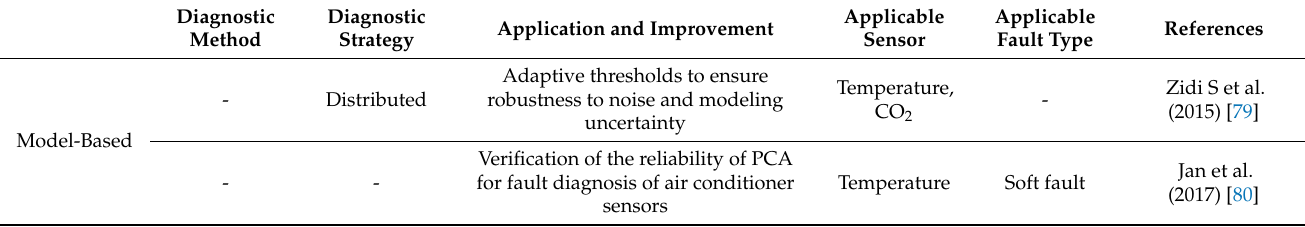
Table 3. Development and application of intelligent sensor fault diagnosis